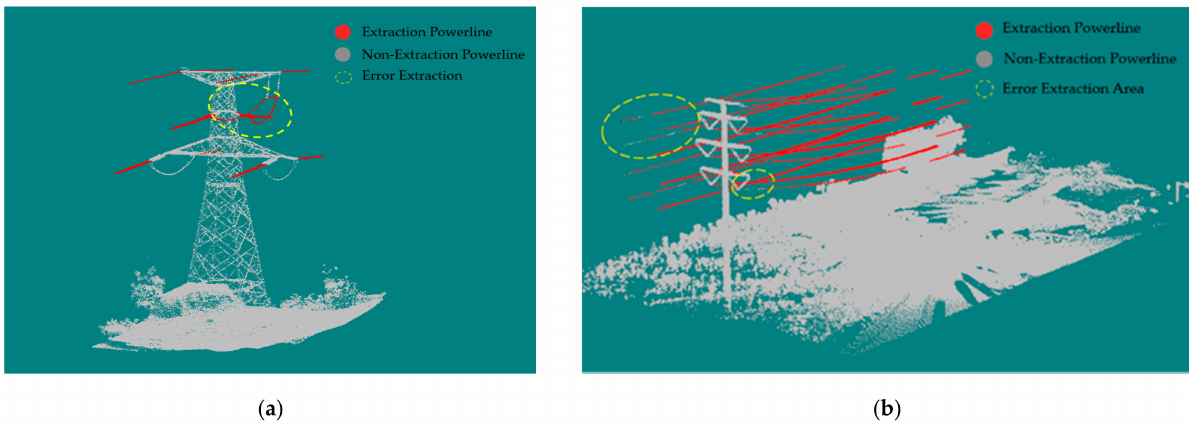
Figure 11. Examples of error extraction in the four datasets. ( a ) The drainage lines which were labelled as PTLs in Dataset 1; ( b ) error extraction in Dataset